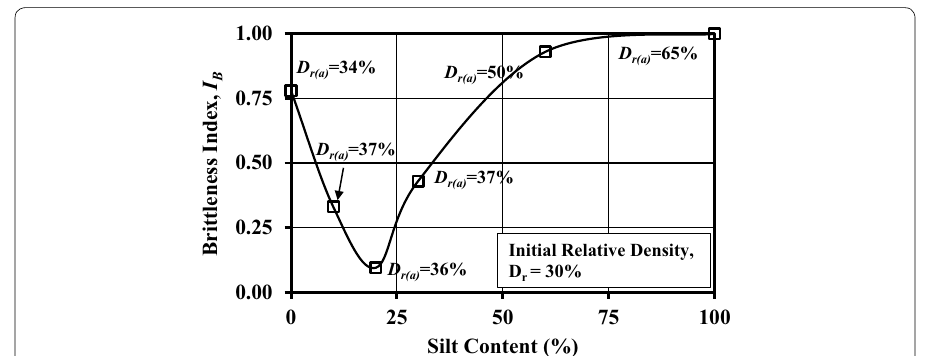
Fig. 9 Brittleness index of sand–silt mixtures at initial relative density, D r